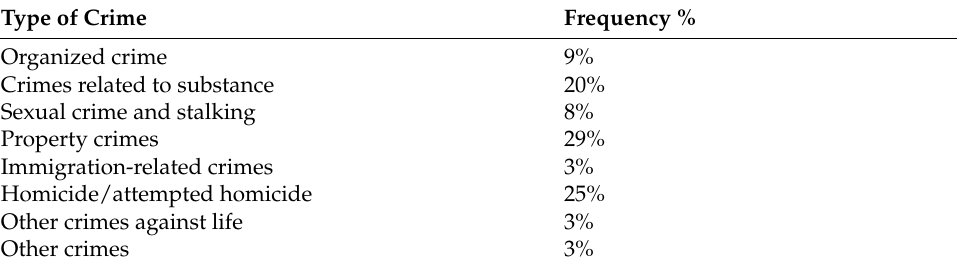
Table 1. Frequencies of type of crime committed among inmates’